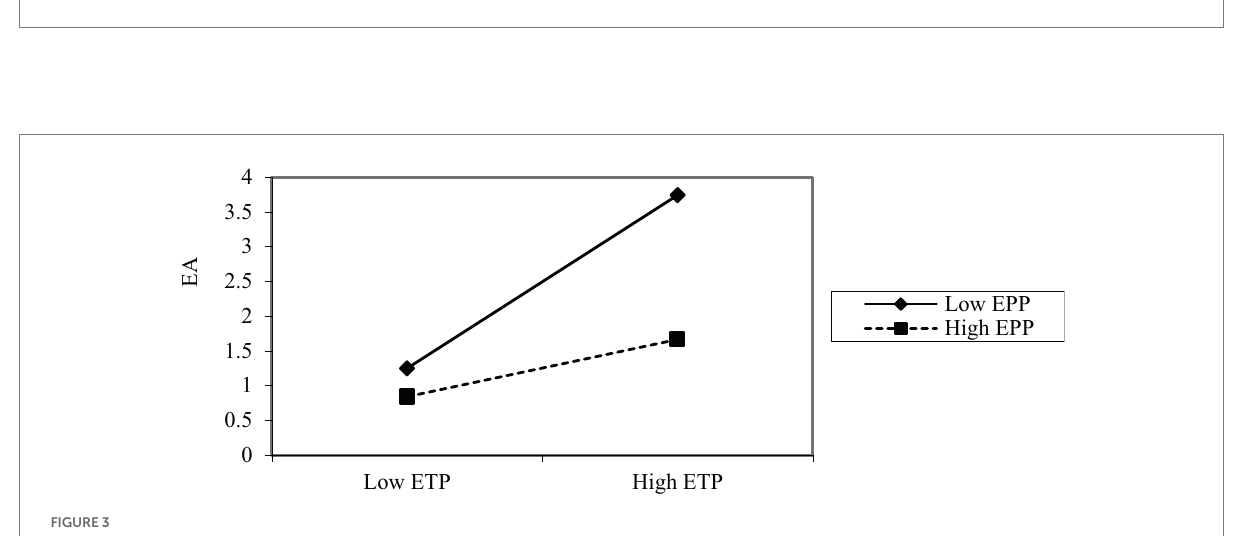
FIGURE 3 The moderating effect of EPP between ETP and